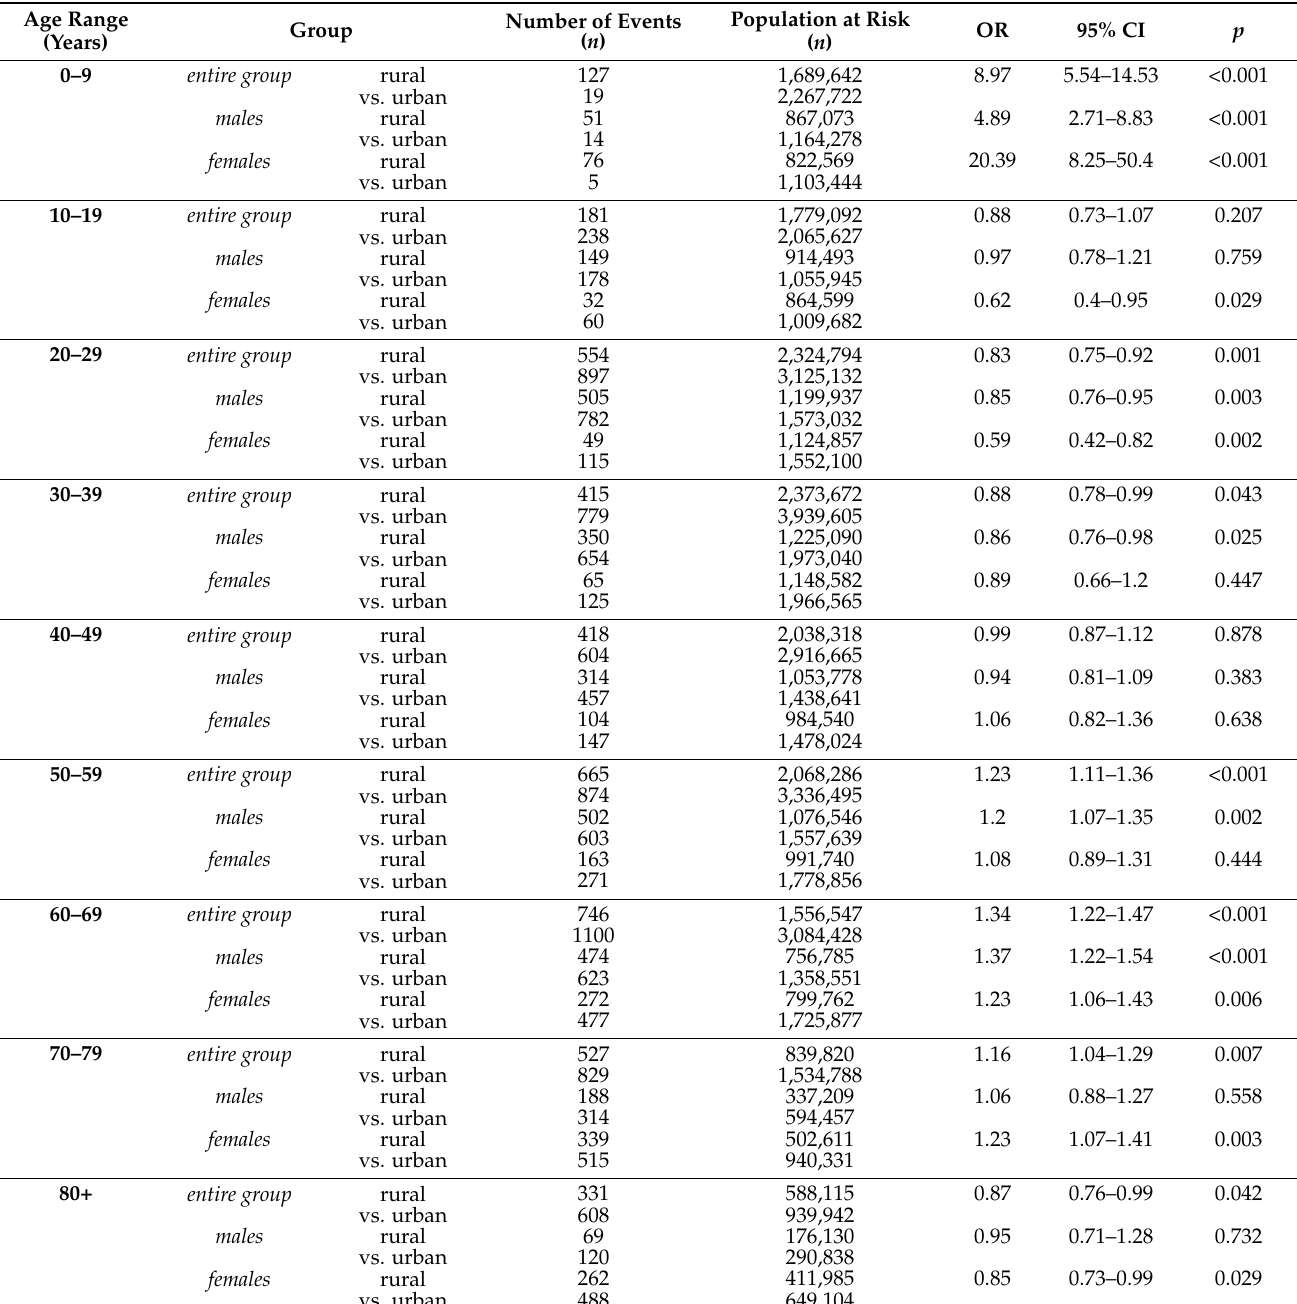
Table 3. Age-related odds ratios (ORs) for the first shoulder dislocation event in rural versus urban